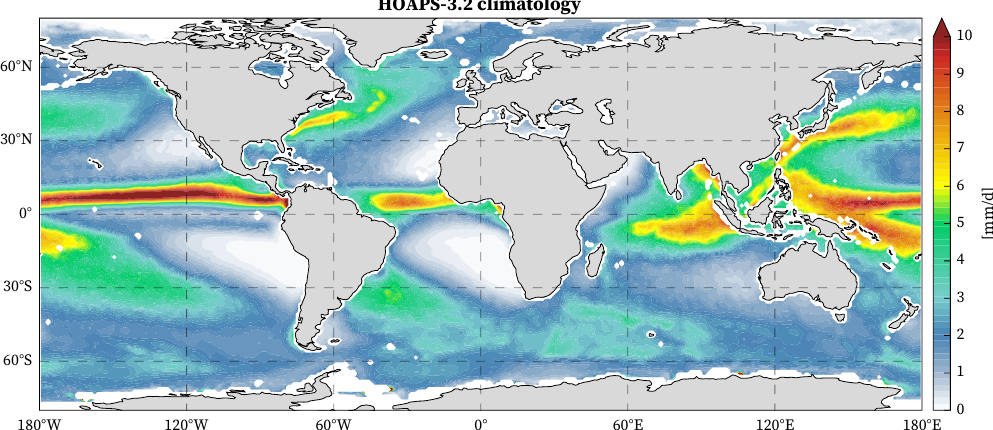
Figure 3. Climatological mean field of Hamburg Ocean Atmosphere Parameters and Fluxes from